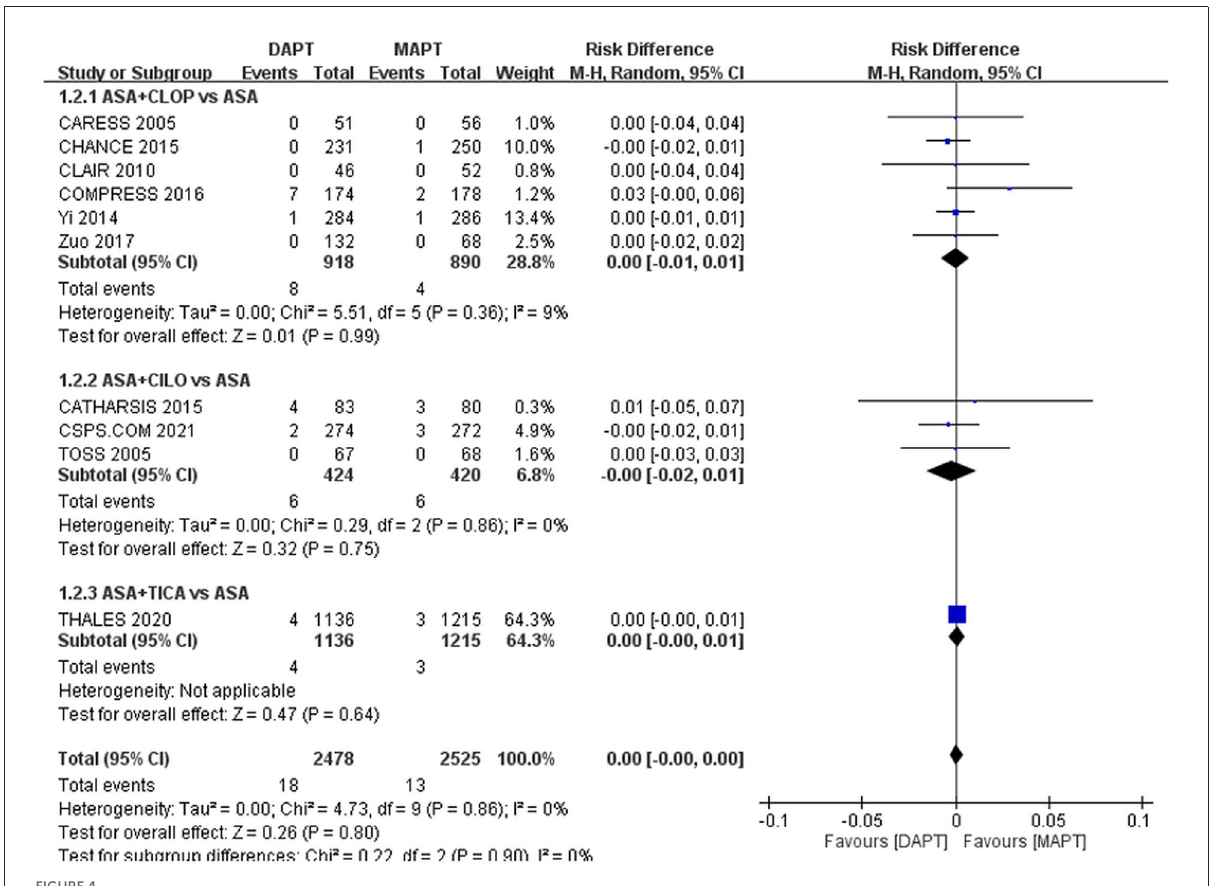
FIGURE4 Forest plot for outcome of major bleeding. The risk of major bleeding wa not significantly different between MAPT and DAPT in patients with symptomatic large artery atherosclerosis. ASA, aspirin; CILO, cilostazol; CLOP, clopidogrel; DAPT, dual antiplatelet therapy; MAPT, mono antiplatelet therapy, M-H, Mantel-Haenszel method; TICA,